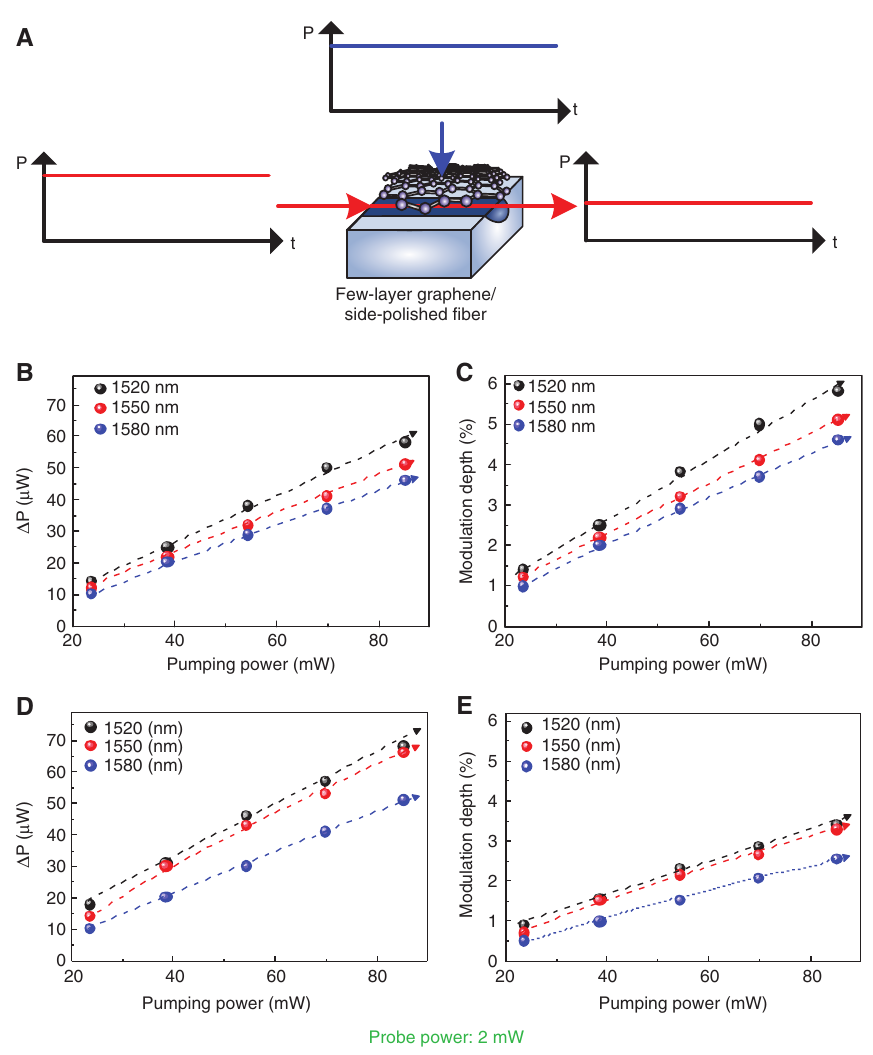
Figure 5: (A) Schematic of the pump-probe system, (B) switching response and (C) modulation depth of few-layer graphene all-optical switcher with different probe wavelengths (probe power of 1 mW), and (D) switching response and (E) modulation depth of few-layer gra- phene all-optical switcher with different probe wavelengths (probe power of 2